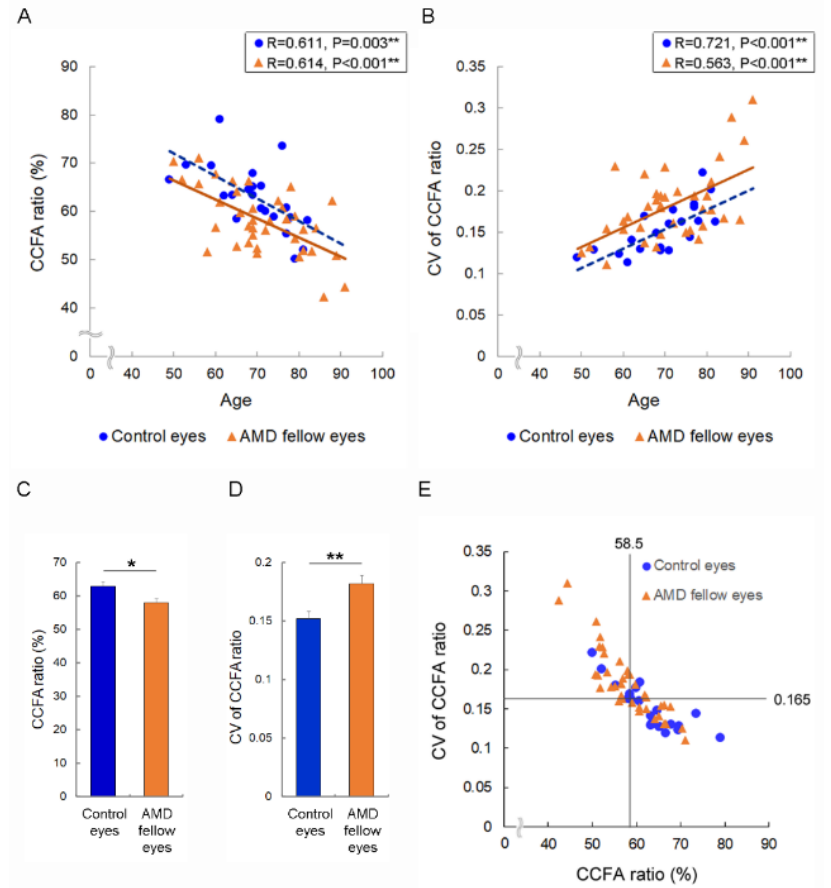
Figure 1. Choriocapillaris flow area (CCFA) ratio and coefficient of variation (CV) of the CCFA ratio of control and age-related macular degeneration (AMD) in fellow eyes. Age was negatively correlated with the CCFA ratio ( A ) and positively correlated with the CV of the CCFA ratio ( B ). The mean CCFA ratio was lower ( C ) and the CV of the CCFA ratio was greater ( D ) in AMD fellow eyes than in control eyes. The cutoff values for the eyes at risk of being AMD fellow eyes are shown in the scatterplot ( E ). * p < 0.05, ** p < 0.01. Table 2. Risk factors for eyes with heterogenous deficits and an imbalance of choriocapillaris flow were defined in accordance with the choriocapillaris flow area (CCFA) ratio < 58.5% and the coeffi- cient of variation (CV) of the CCFA ratio ≥ 0.165 .